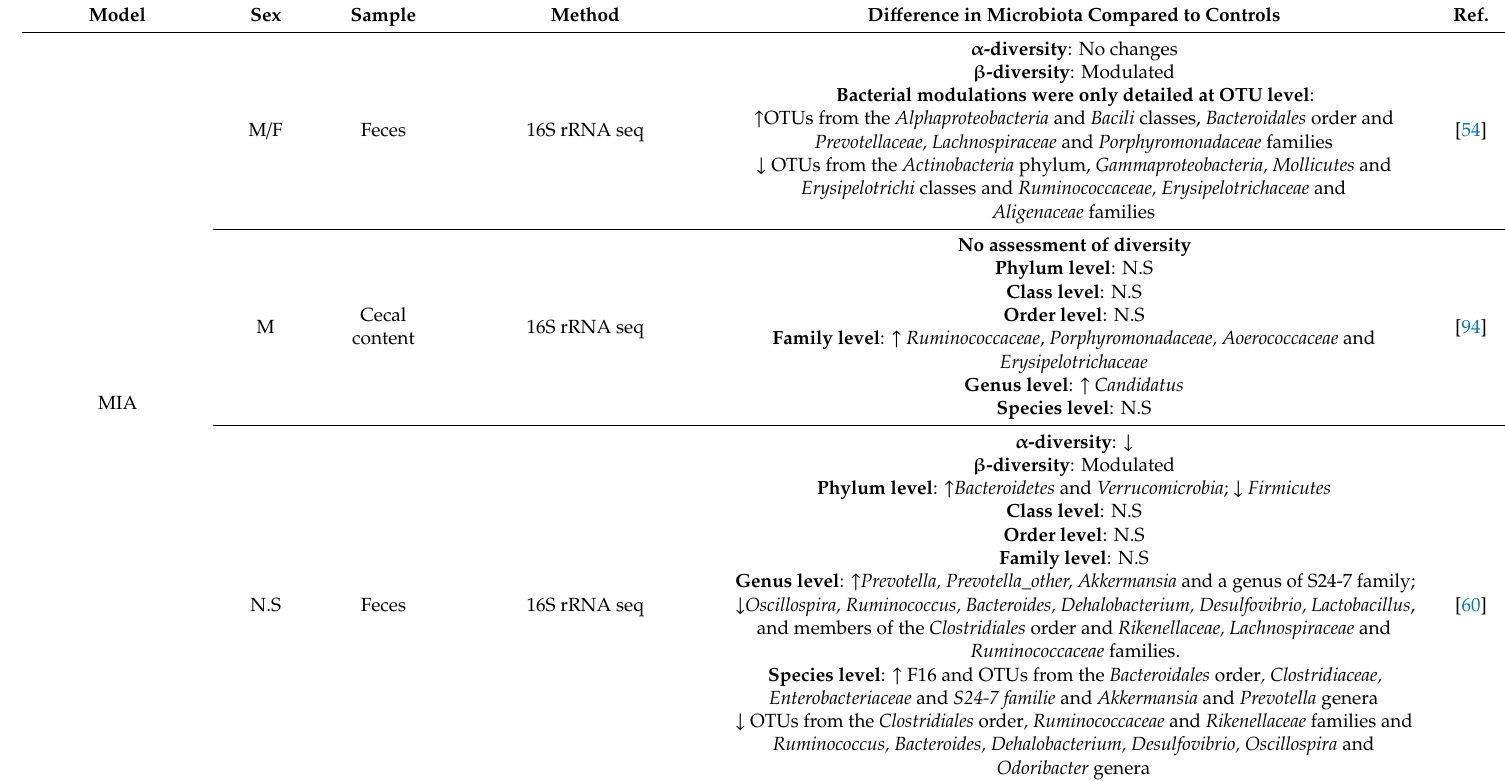
Table A2. Microbiota modulations in environmental models of